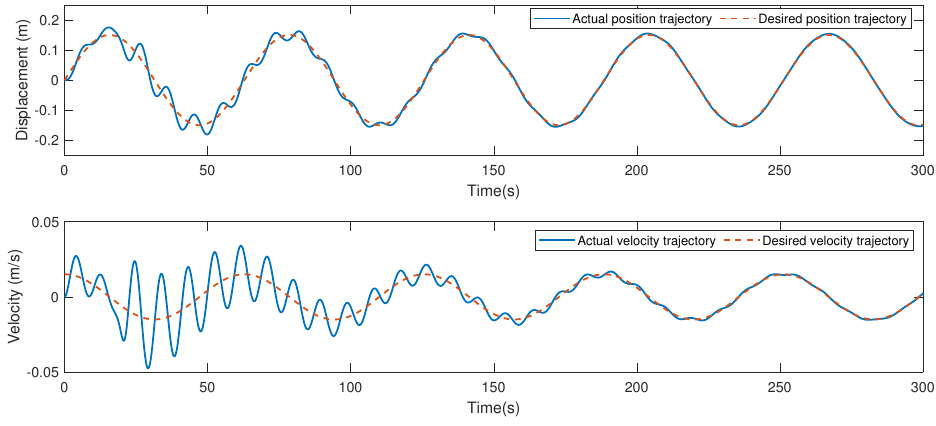
Figure 13. The position and velocity trajectory of the robot.